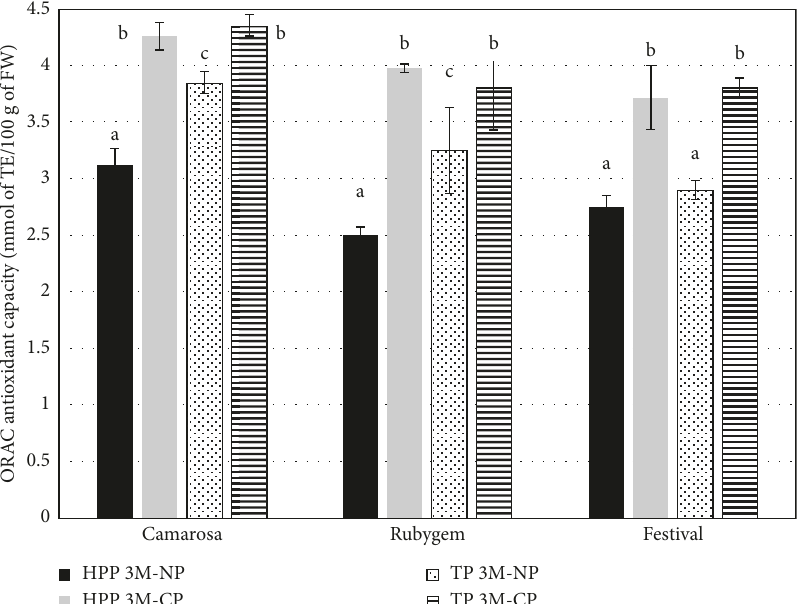
Figure 3: The effects of copigmentation on ORAC antioxidant capacity following three months of refrigerated (4 ° C) storage of HPP and TP strawberry puree samples. CP-3M: copigmented samples and NP-3M: non-copigmented samples stored for three months at 4 ° C. Different letters within a group designate a significant difference ( p 0 . 05). <